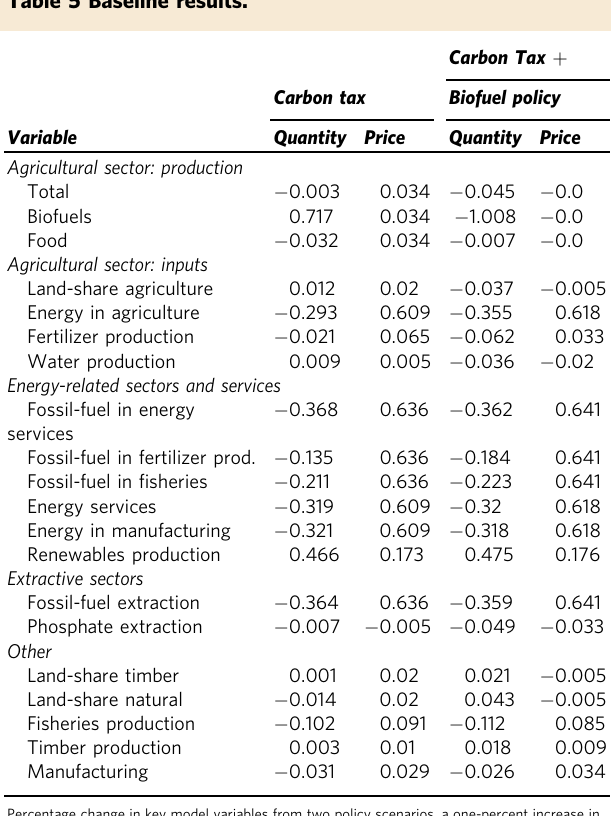
Table 2 for the carbon tax policy and Supplementary Table 3 for the combined carbon tax and biofuel tax policy.